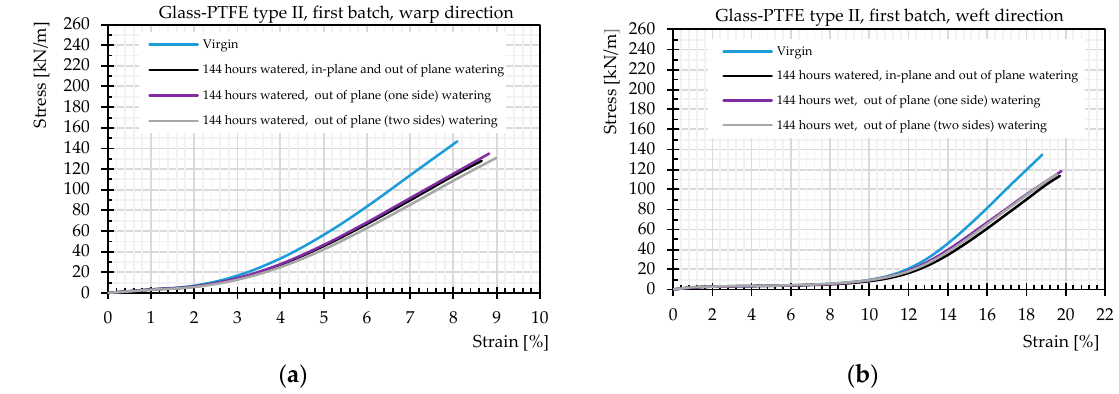
Materials 2021 , 14 , x FOR PEER REVIEW Figure 15. Stress–strain curves of strip- and tank-shaped specimens, glass-PTFE samples according to Table 3.